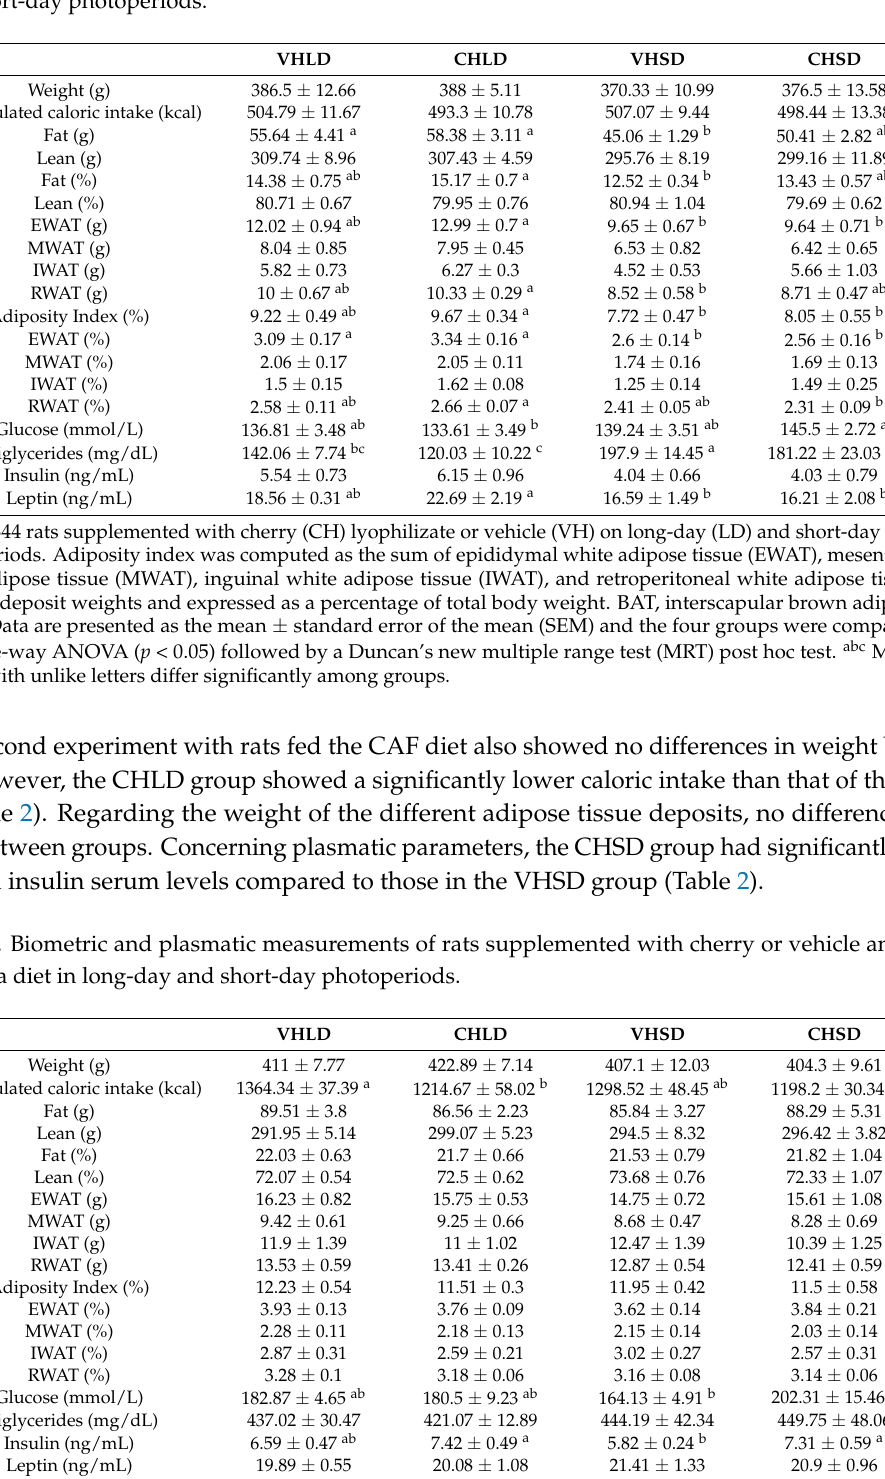
Table 1. Biometric and plasmatic measurements of rats supplemented with cherry or vehicle on long- and short-day photoperiods.